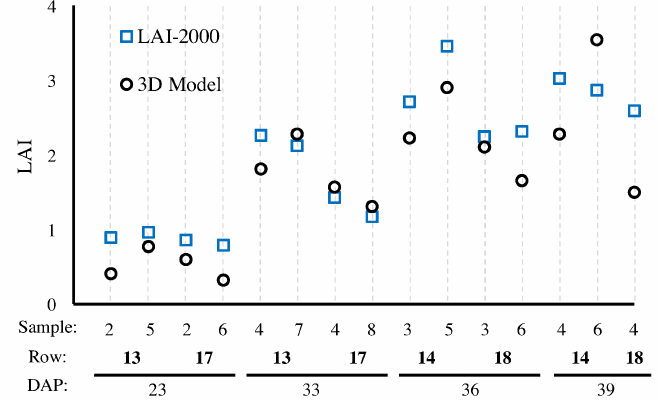
Figure 19. Comparison of LAI estimation between LAI-2000 and 3D Model created by Vinoculer stereo images. The horizontal axes shows the number of samples collected per row; the row number according to Figure 5; and